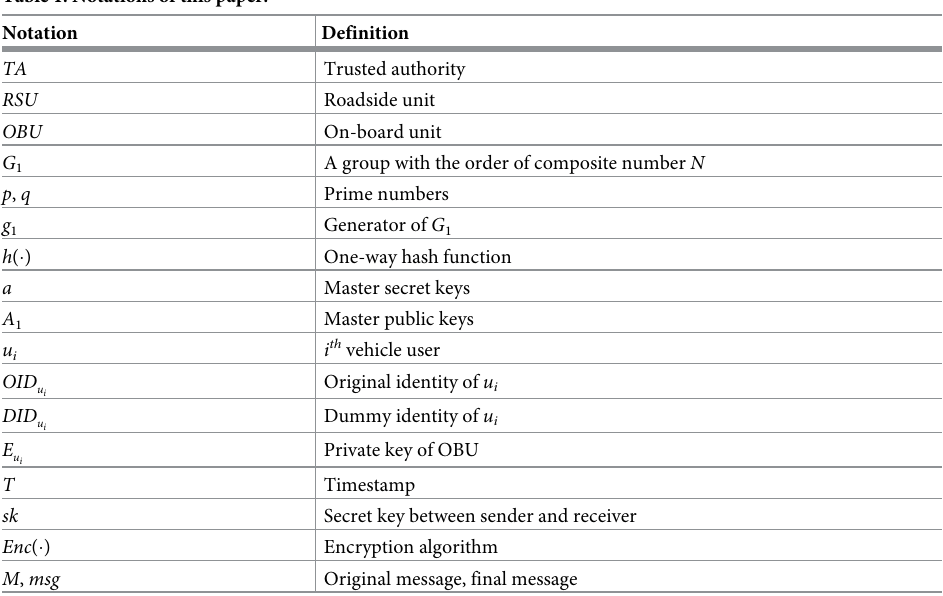
Table 1. Notations of this